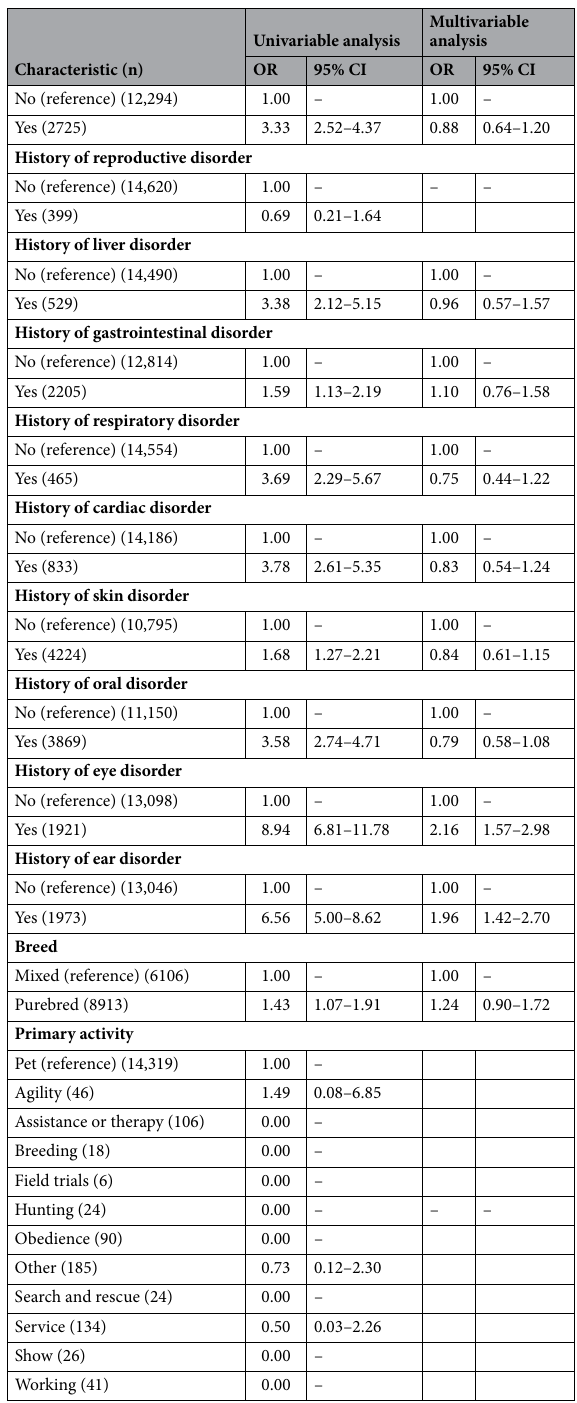
Table 2. Association between selected dog characteristics and Canine Cognitive Dysfunction, Dog Aging Project